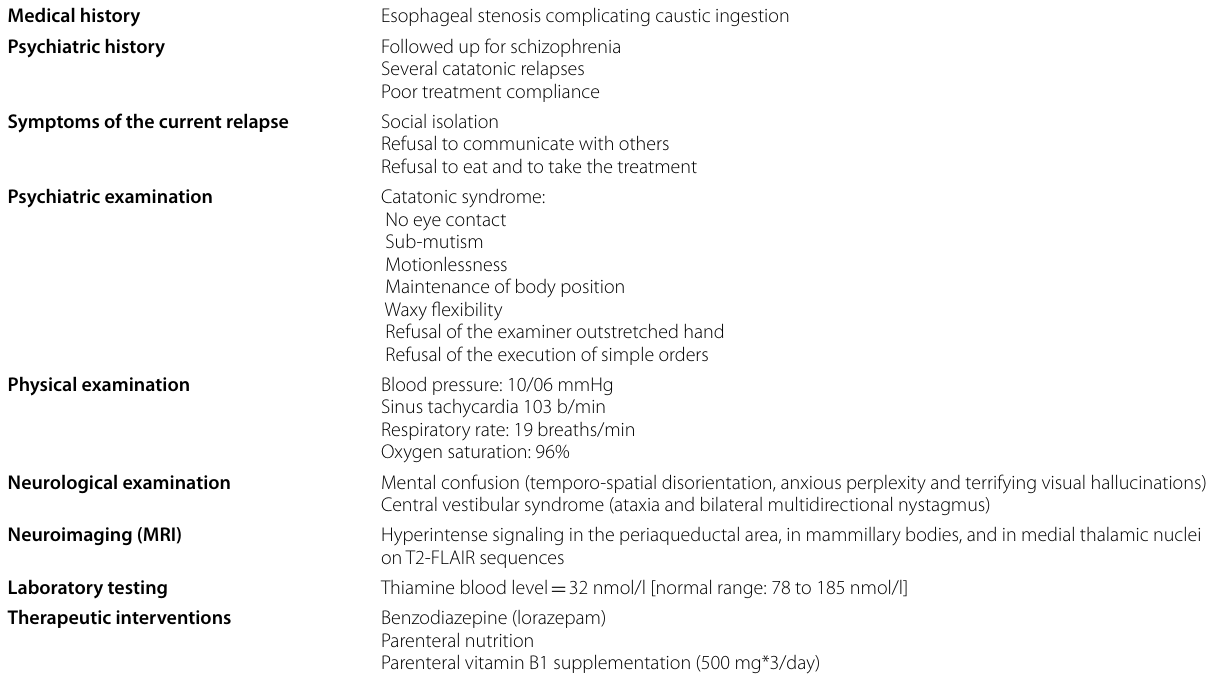
Table 1 Main clinical and paraclinical data of the case